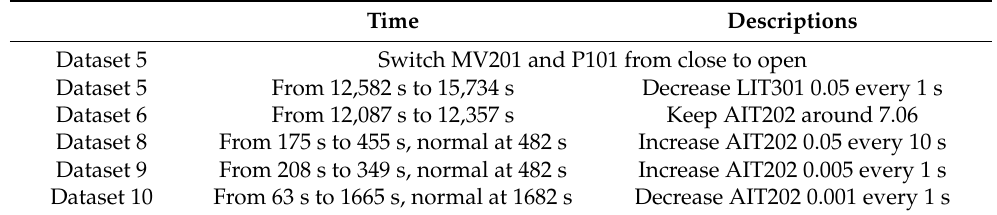
Table 3. Details of sophisticated attacks.